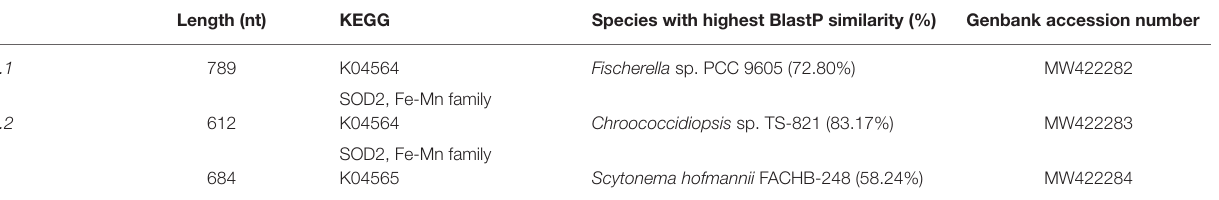
TABLE 2 | SOD-coding genes in Chroococcidiopsis sp. CCMEE 029.